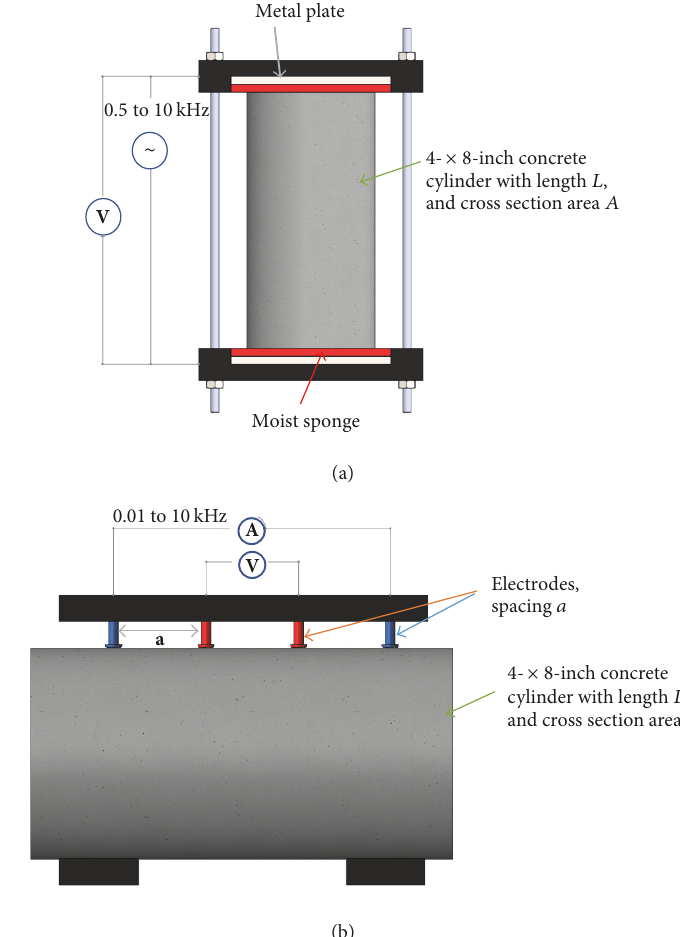
Figure 1: Electrical resistivity measuring techniques: (a) two-point uniaxial method and (b) four-point (Wenner probe) method (reproduced from [6]).